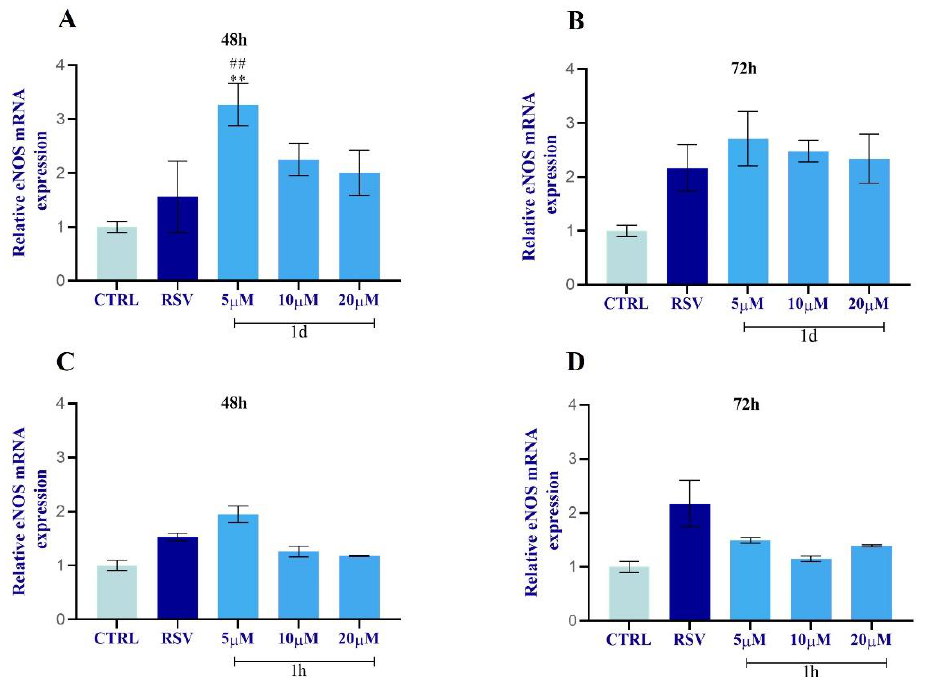
Figure 13. Effects of 1d ( A , B ) and 1h ( C , D ) on eNOS expression at 48 h and 72 h. The histograms represent normalized data for the housekeeping GAPDH. The values represent the average of three independent experiments with the relative SD (Error bars). * Significance with respect to CTRL: ** p < 0.001; # significance with respect to RSV: ## p < 0.001.